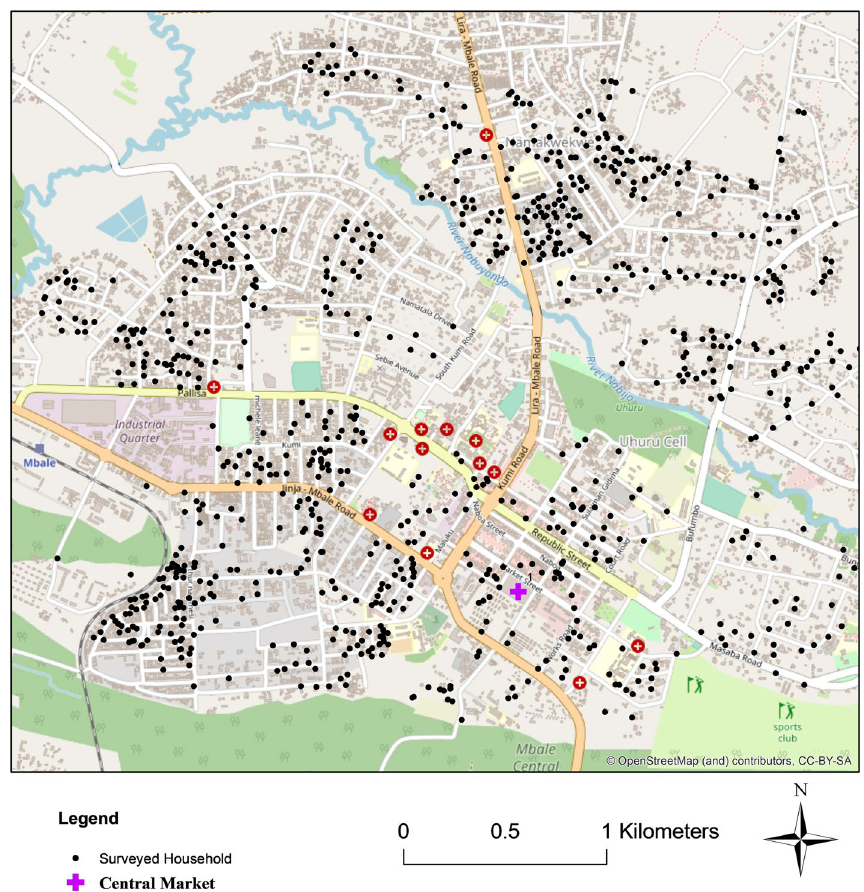
Fig. 1 Map of Mbale, Uganda. Dots show the households surveyed. Source: Open street maps. Created by Mackay, H., April